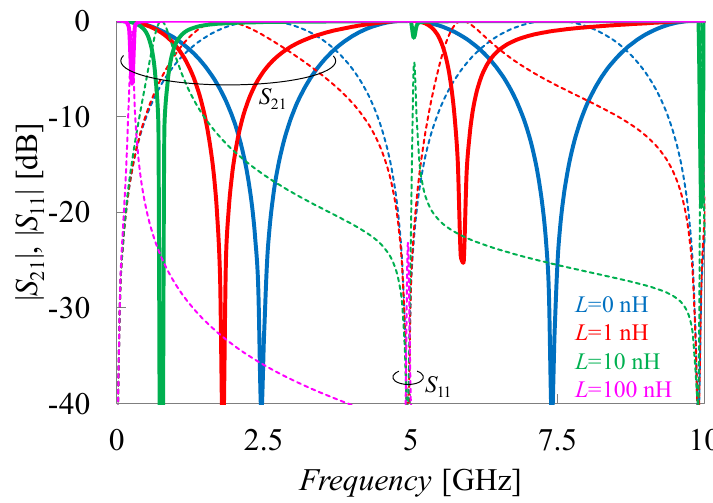
Figure 4. Calculated results of | S 21 | and | S 11 | for different inductances when Z 1 / Z 0 = 1/2. Four patterns show the case L = 0 nH, 1 nH, 10 nH, and 100 nH.